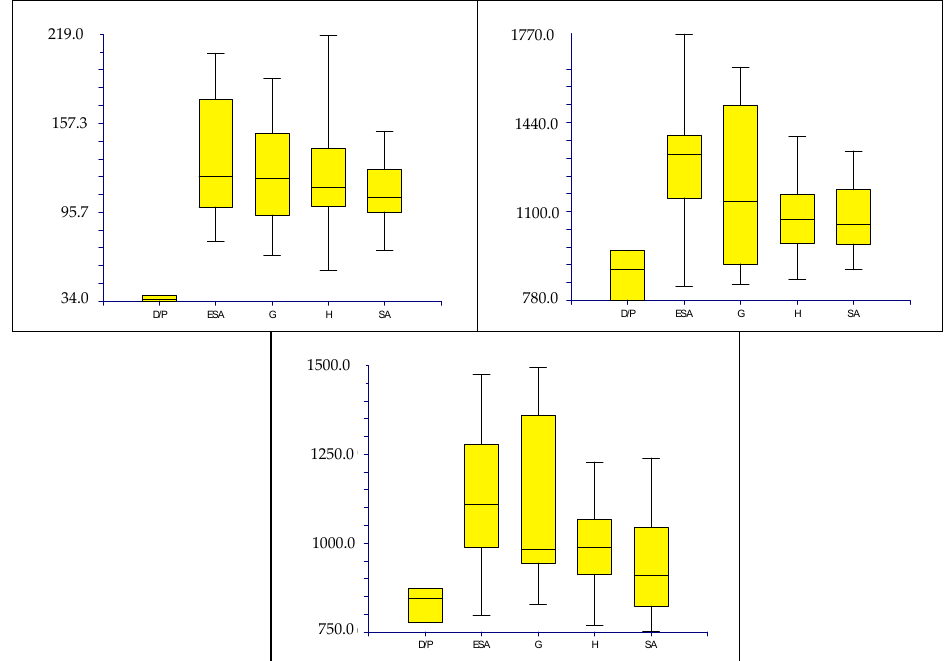
Figure 11. Box plots [characters ( y -axes) per “molecular clades” ( x -axes)] illustrating the variability of the length of flat border opposite to hilum (left graph), length of seed (central graph), and width of seed (right graph) (measurements are in µm). Abbreviation: D/P = Dioecius / Pumilus -clade; ESA = Eurasian/South African/Australian -clade; G = Galápagos -clade; SA = South American -clade; H = Hybridus -clade [clades according to Waselkov et al. [15] (pag. 446, Figure 1A].